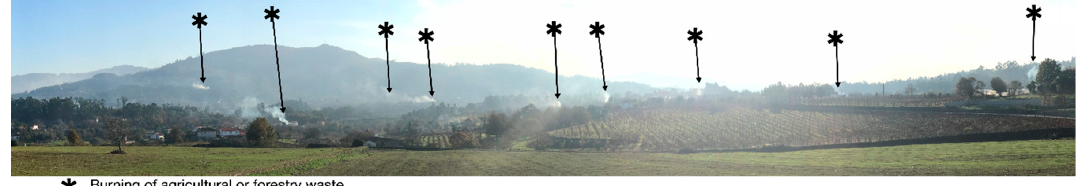
Figure 1. Panoramic picture taken on 12 / 5 / 2017 from ESA—Ponte de Lima School of Agriculture of the Polytechnic Institute of Viana do Castelo (north Portugal), where it is possible to observe 9 fires in a rural environment occurring simultaneously.